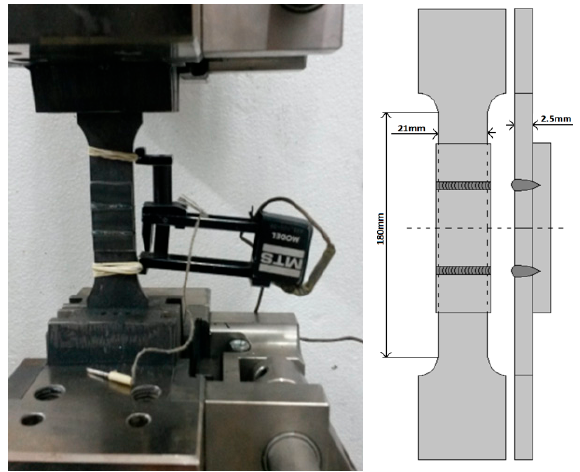
Figure 6. Tensile-strength test stand and specimen scheme.